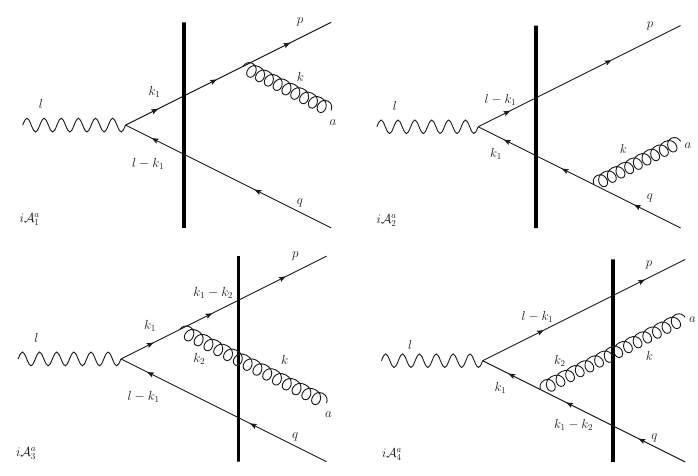
Figure 1 . The real corrections i A a flow, all momenta flow to the right. The thick solid line indicates interaction with the target.